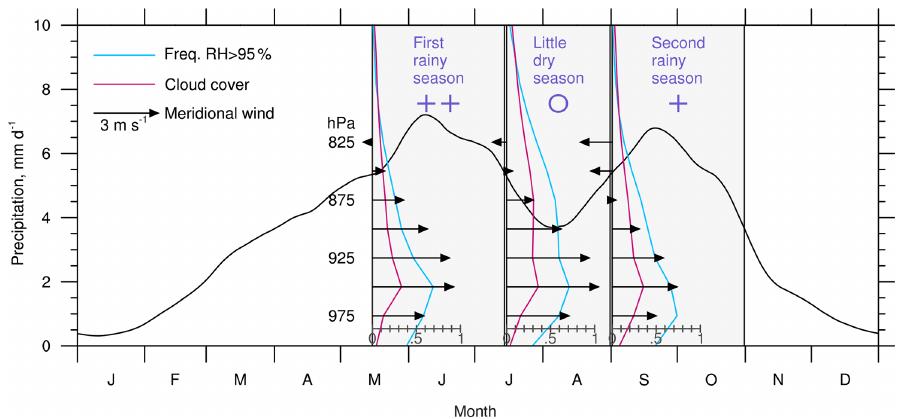
Figure 3. Climatological overview. Average annual cycle of meteorological conditions over southern West Africa (red bordered region in Fig. 1). Solid black line shows mean rainfall (CHIRPS), while the profiles give average conditions (ERA5, mean 06:00UTC values from 1983–2015) for meridional wind (southerly (northerly) wind as vectors to the right (left), strength according to the reference vector); cloud cover (pink); and the frequency of relative humidity exceeding 95% (cyan) for the first rainy season (FRS, 15 May–14 July), the little dry season (LDS, 15 July–31 August), and the second rainy season (SRS, 1 September–31 October). Cloud cover and relative humidity range from 0 to 1 according to the scales at the bottom for each season. Symbols below the seasons’ names mark the degree of convective organization ( ++ strong, + moderate, ◦ weak) according to Maranan et al. (2018).